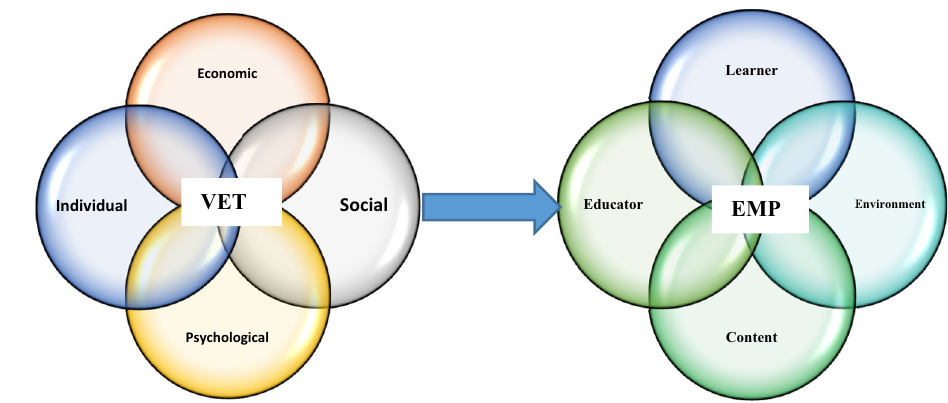
Fig. 1 Dimensions of VET and EMP. Impact of the dimensions of vocational training on the rural women empowerment.